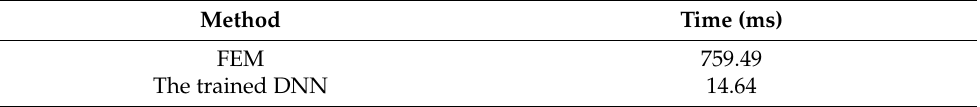
Table 8. The average computation time of the FEM and the trained DNN for one testing case.